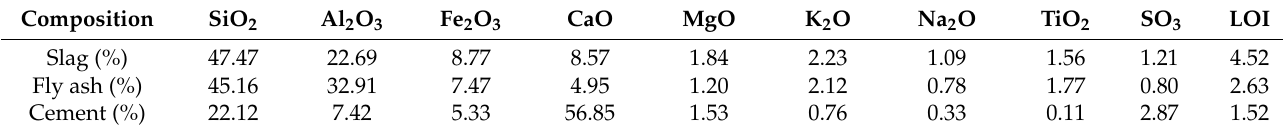
Figure 2. X-ray diffraction patterns of ( a ) slag and ( b ) fly ash. Table 1. Chemical compositions of slag, fly ash, and cement.